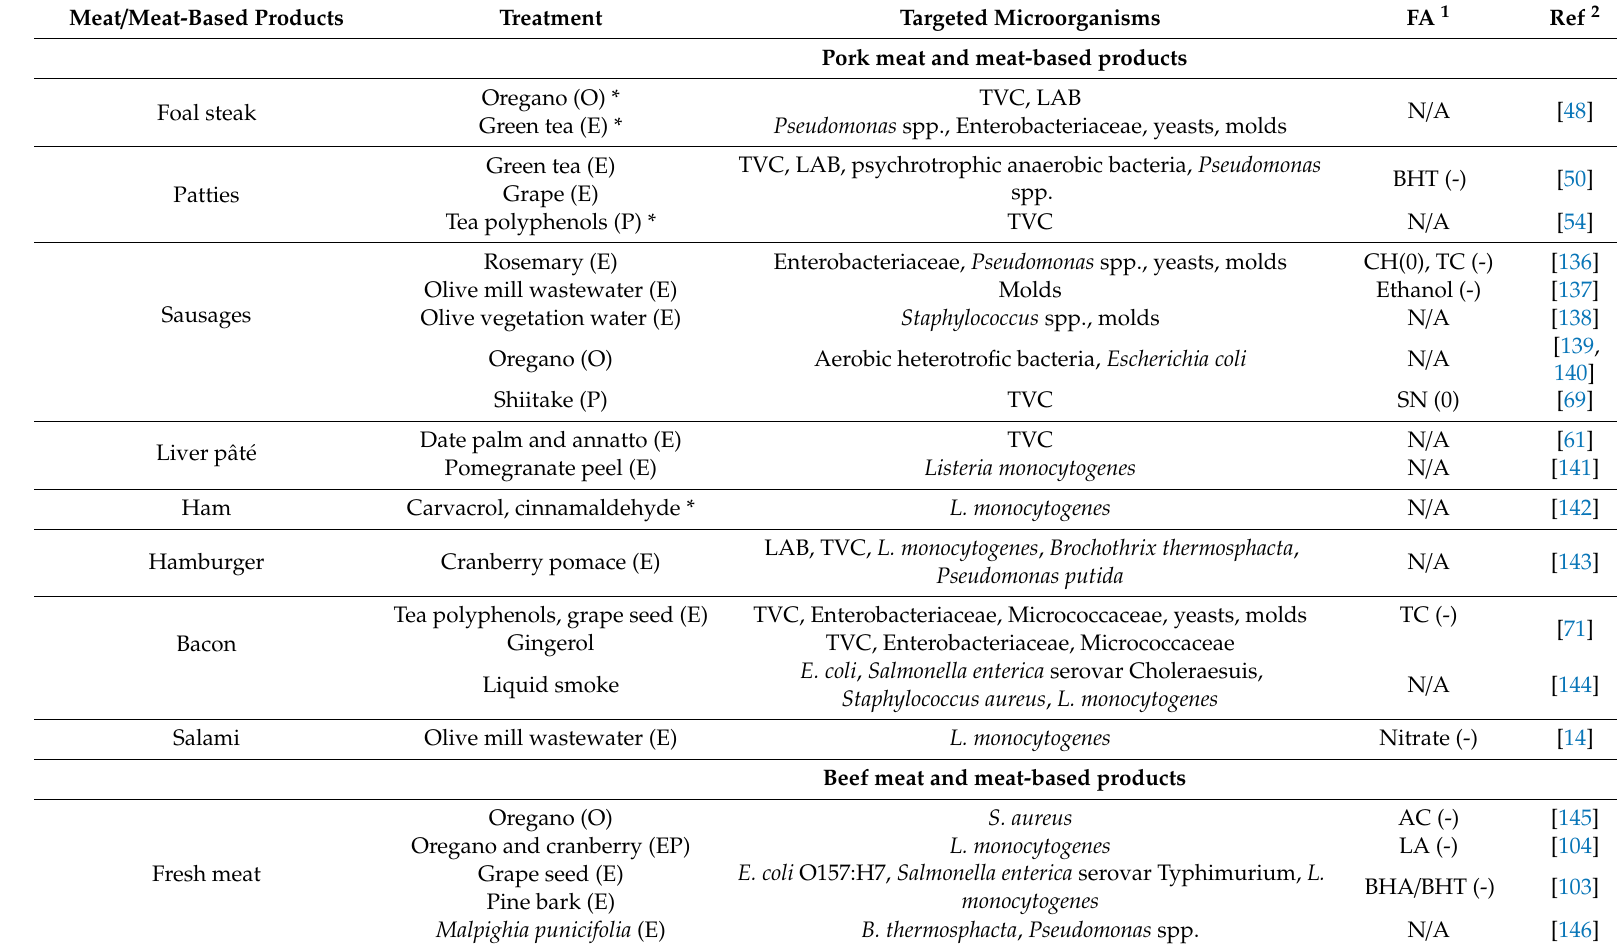
Table 3. In situ antimicrobial activity of natural phenolic compounds in meat-based products. Meat / Meat-Based